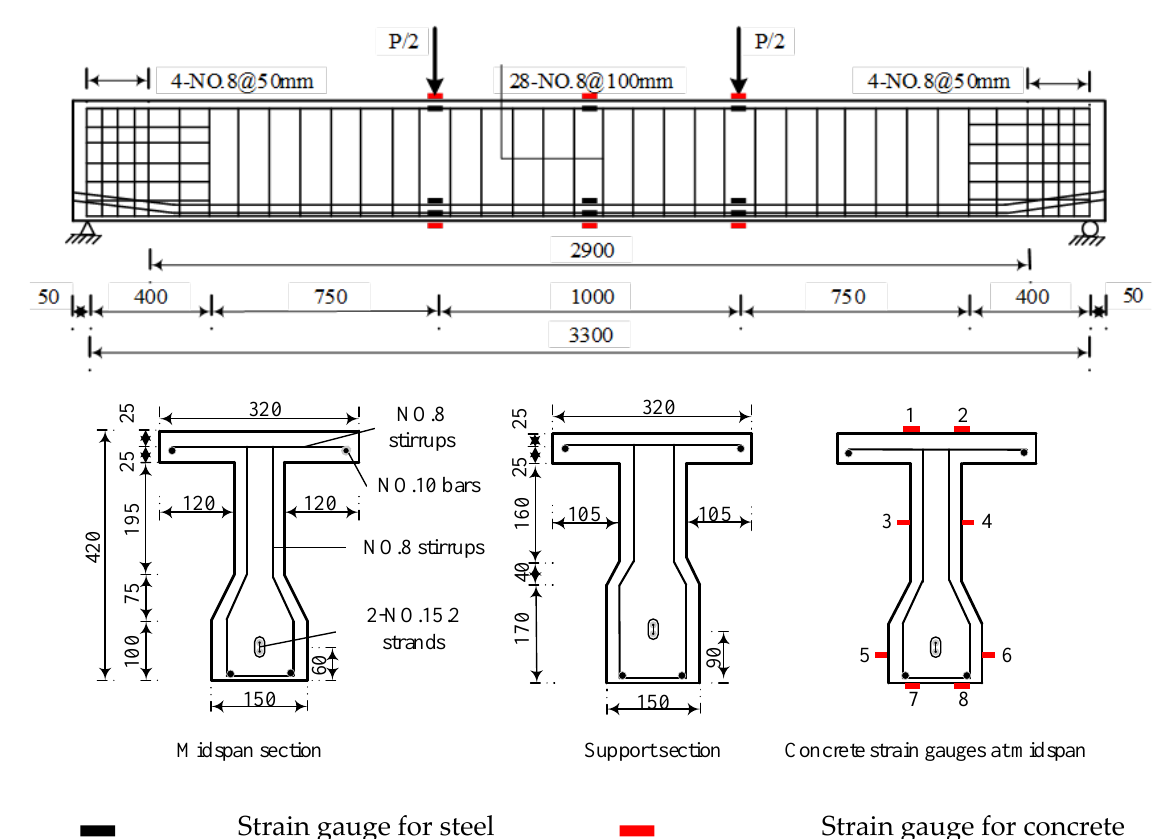
Figure 1. Details of the test specimens (unit: mm).